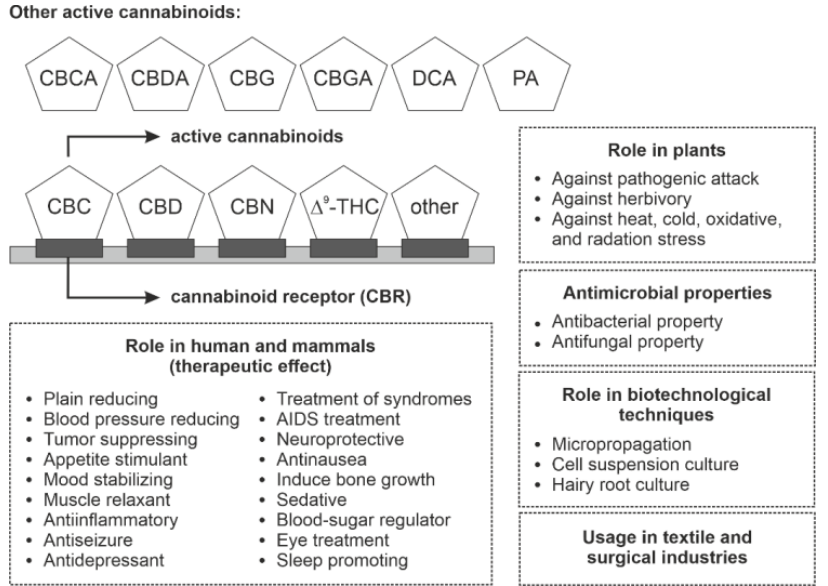
Figure 8. Selective role of active phytocannabinoids in humans, mammals, plants, biotechnology, and industries. Abbreviations: CBC, cannabichromene; CBCA, cannabichromenic acid; CBD, cannabidiol; CBDA, cannabidiolic acid; CBG, cannabigerol; CBGA, cannabigerolic acid; CBN, cannabinol; CBR, cannabinoid receptor; DCA, daurichromenic acid; PA, perrottetinenic acid; ∆ 9 -THC, Δ 9 -tetrahydrocannabinol.